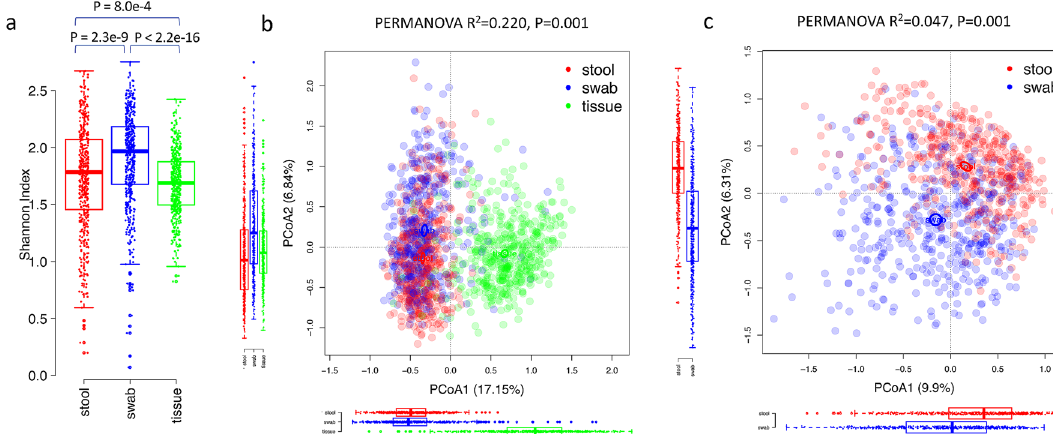
Figure 1. Alpha-diversity and PCoA ordinations of the taxonomic composition of microbial metagenomes at the genus level composition. Color indicates the sample types. (a) Alpha diversity across sample types. Differences between sample types were tested with Wilcoxon Rank Sum test. (b) Mucosal tissue samples formed a distinct cluster from stool and swab samples. Ellipses indicate 95% confidence limits of the centroids (added with function ‘ordiellipse’ in R package ‘vegan’). (c) Separation of stool and swab samples. The boxplots below and on the left of the PCoA plots showed the distribution of coordinates of stool, swab and mucosal